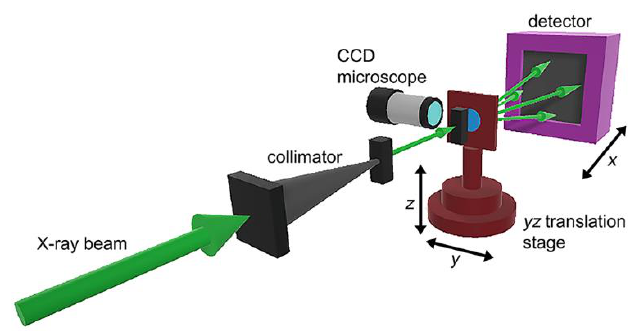
Figure 20. Schematic drawing of the scanning synchrotron X-ray microdiffraction ( μ -XRD) setup.